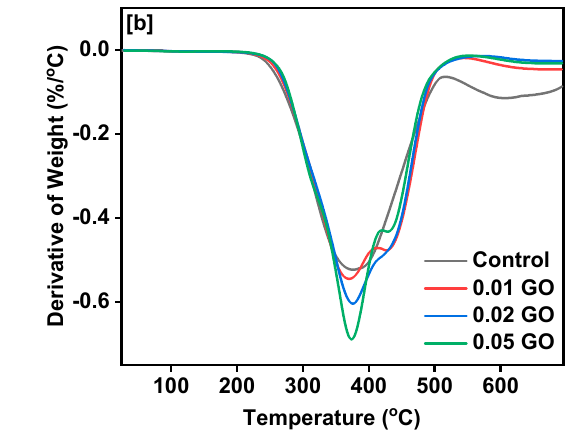
Figure 4. ( a ) TGA and ( b ) DTG curves of films.